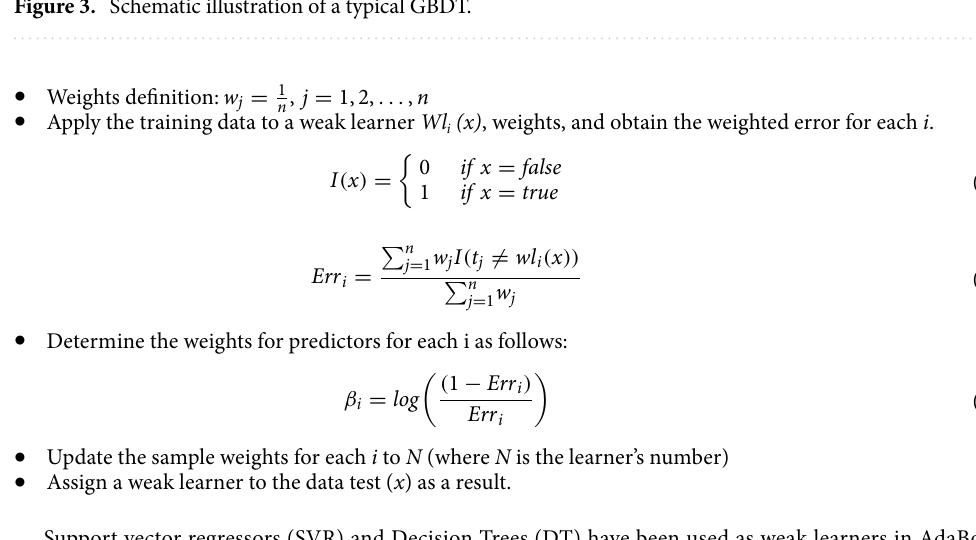
Figure 3. Schematic illustration of a typical